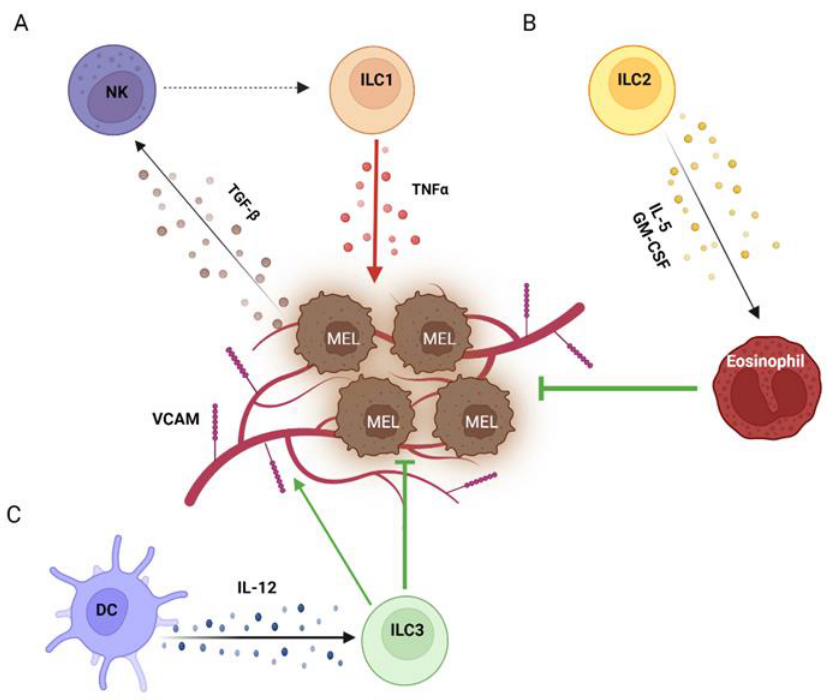
Figure 1. Helper ILCs in the melanoma TME. Within the melanoma TME, TGF- β secreted by melanoma cells switches NK cells into ILC1s, which in turn support melanoma growth by producing TNFα ( A ). On the other side, ILC2s exert anti-melanoma effects by recruiting eosinophils through IL-5 and GM-CSF ( B ). Moreover, ILC3s activated by DCs via IL-12 induce the expression of VCAM on the melanoma vasculature, promoting leukocyte infiltration ( C ).